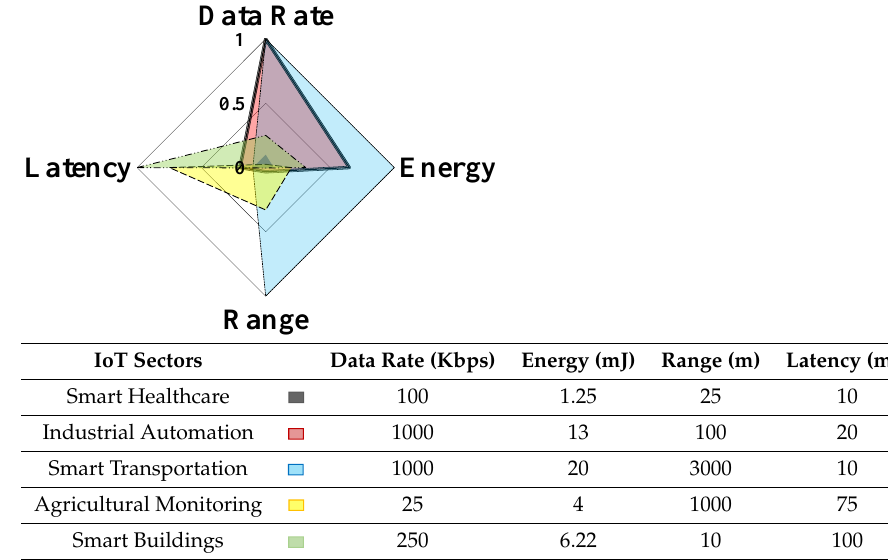
Figure 2. Different KPIs for IoT use cases